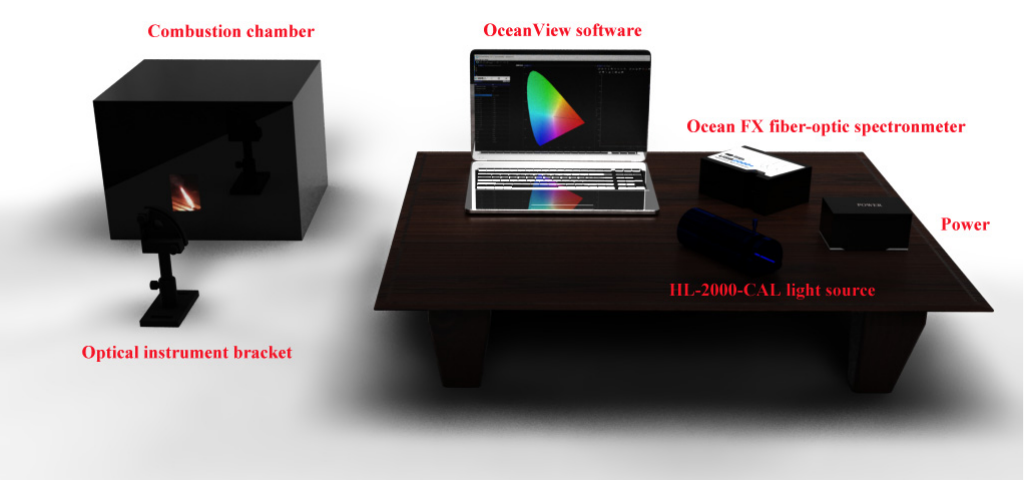
Figure 6. Combustion radiation spectrum test device.